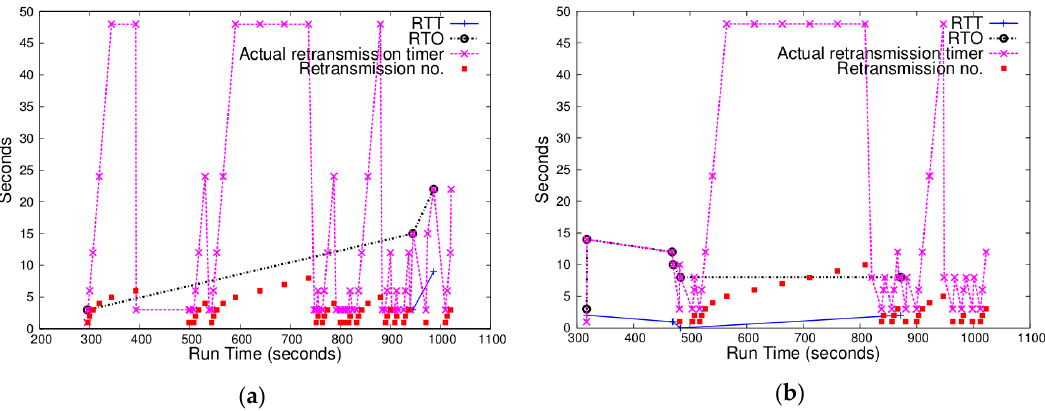
Figure 3. Changes of RTT, RTO, actual retransmission timer, and retransmission counter for some nodes in a 5 × 5 grid topology with ContikiMAC enabled. ( a ) This node had few chances to measure RTT without taking sample RTTs using retransmitted segments. ( b ) In this node, a segment was successfully delivered after 10 retransmissions.